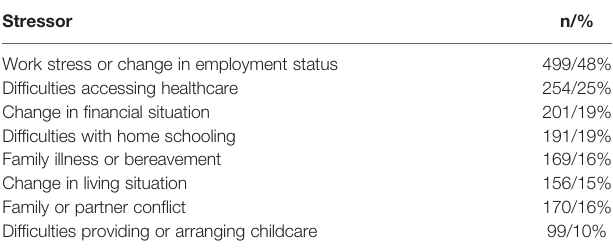
TABLE 6 | Stressors. “ Have you had any of the following stressors over the course of the pandemic? ”